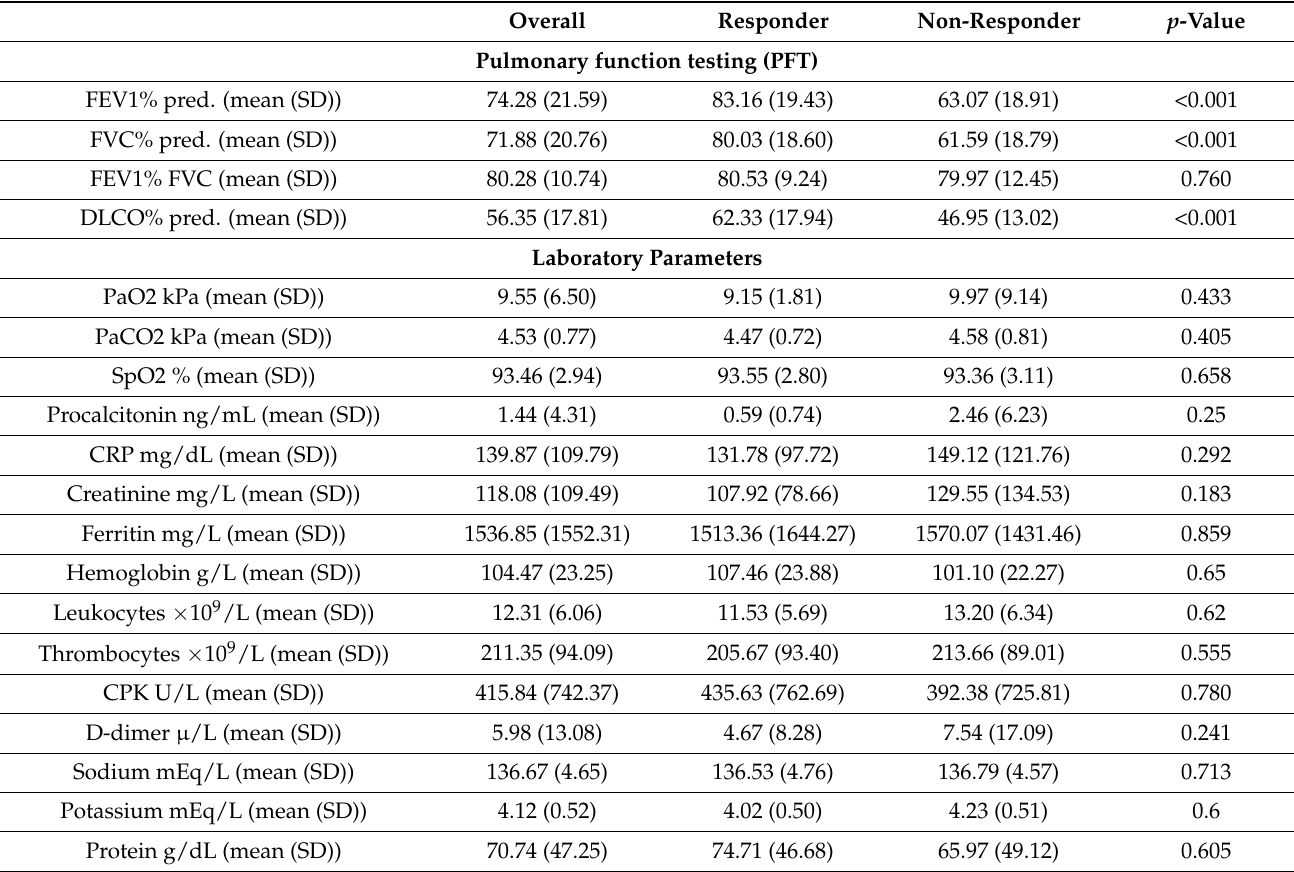
Table 2. Pulmonary function testing (PFT) and Laboratory Parameters of Responders and Non-Responders. Overall